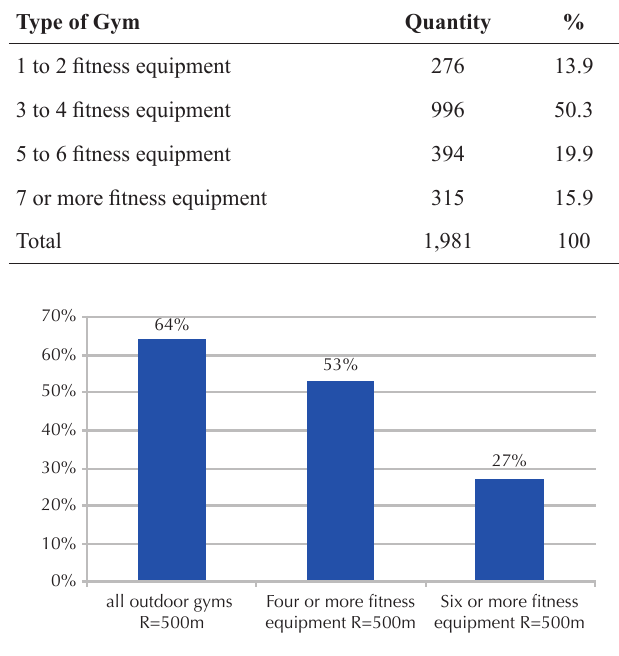
Figure 5: Percentage of urban grid of Santiago with at least one outdoor gym within a 500 m distance. Source: own elaboration. Table 2: Main results of survey. Source: own elaboration Q Content of Question